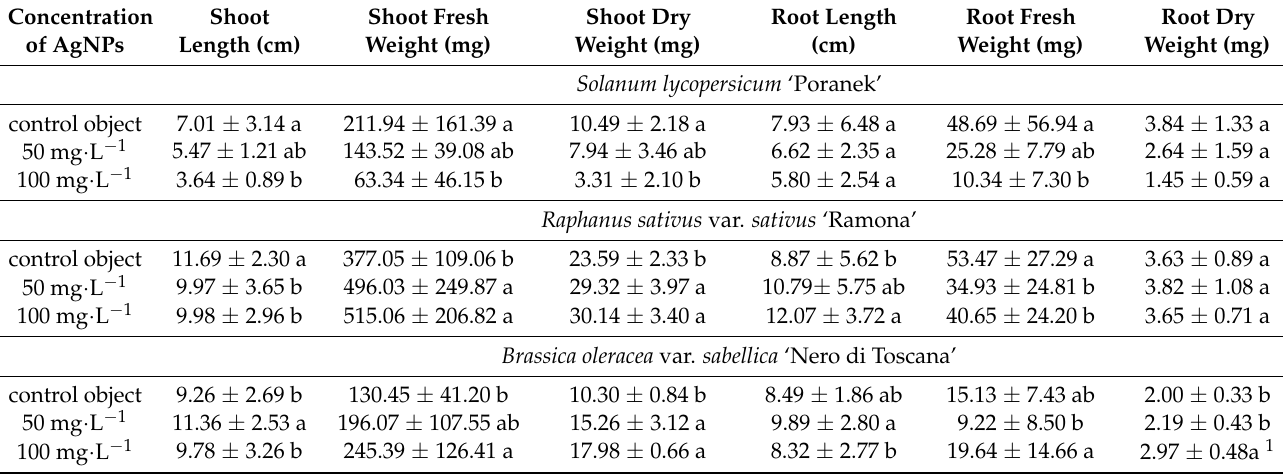
Table 1. Influence of AgNPs application in the tested vegetable plant species on the biometric parameters of the seedlings after three weeks of in vitro culture on the modified MS